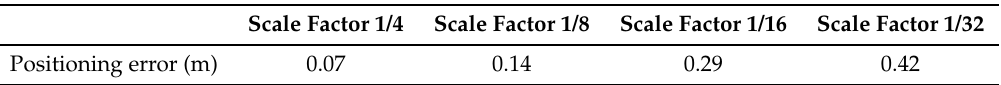
Table 1. Vision-aided positioning error varying the scale factor of the processed image with respect to its original